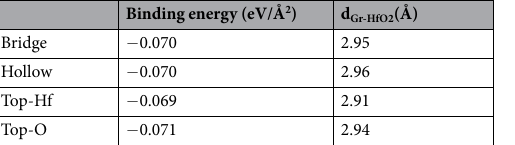
Table 1. Calculated results of binding energy and the average separation between graphene and topmost O